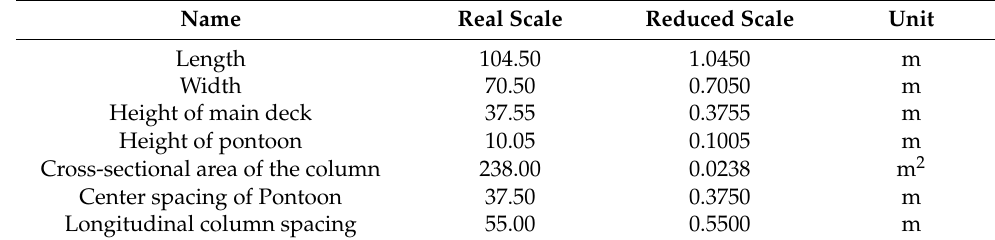
Figure 2. The operational procedure of the numerical model.